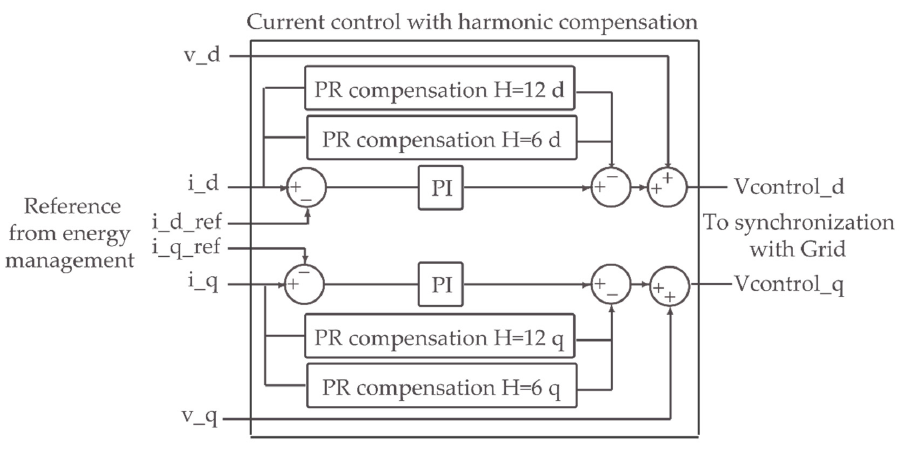
Figure 7. Scheme of the “Current control with harmonic compensation” subsystem.